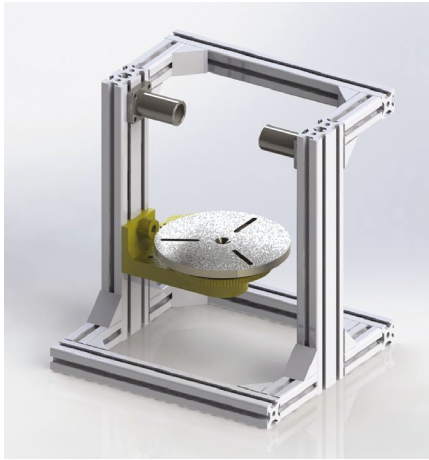
Figure 1: Schematic of the instrument optical front end: (a) laser source; (b) photodetector; (c) rotating table; (d) height